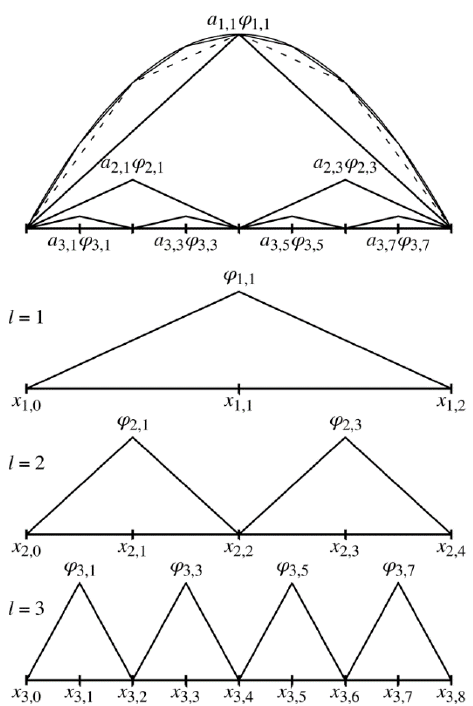
Figure 2. Interpolation on a hierarchical basis.